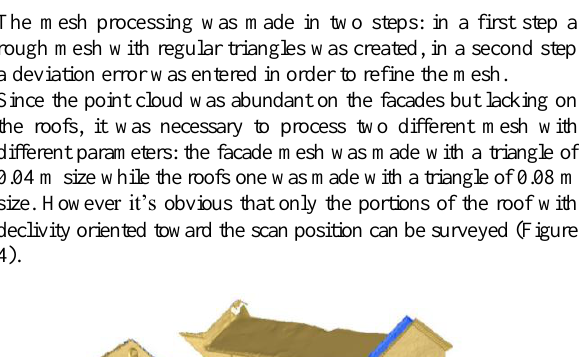
Figure 3. Coloured and merged point clouds of the north facade - image extracted from 3D Reshaper